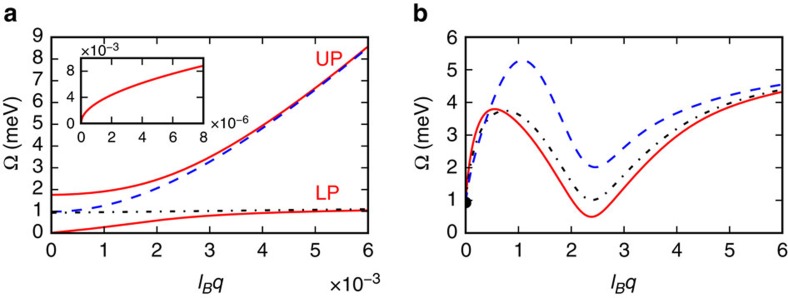
Collective excitation spectrum of the homogeneous fluid phase.(a) Dispersion relations of upper and lower dressed polariton modes (solid lines) in the long-wavelength  limit. The dashed line (dash-dotted line) represents the cavity photon dispersion (bright electronic collective mode), when the electron–photon coupling gq is set to zero. In this panel ϕq=φ. The inset shows a zoom of the lower polariton dispersion relation for . Note that the dispersion behaves as (q)1/2 in this limit. (b) Dispersion relation of the lower polariton mode, along three directions: ϕq=φ (solid line), ϕq=φ+π/4 (dash-dotted line) and ϕq=φ+π/2 (dashed line). All the data in this figure have been obtained by setting κr=5, B=0.5 Tesla, M=1, nX=0.1 and Δ=g.